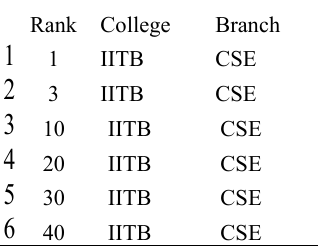
Table 7. Result from random forest